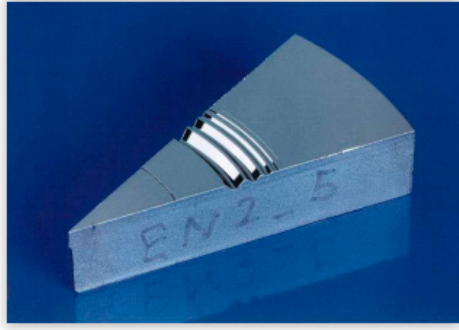
Figure 7. PTB Cu depth-setting standard [23].